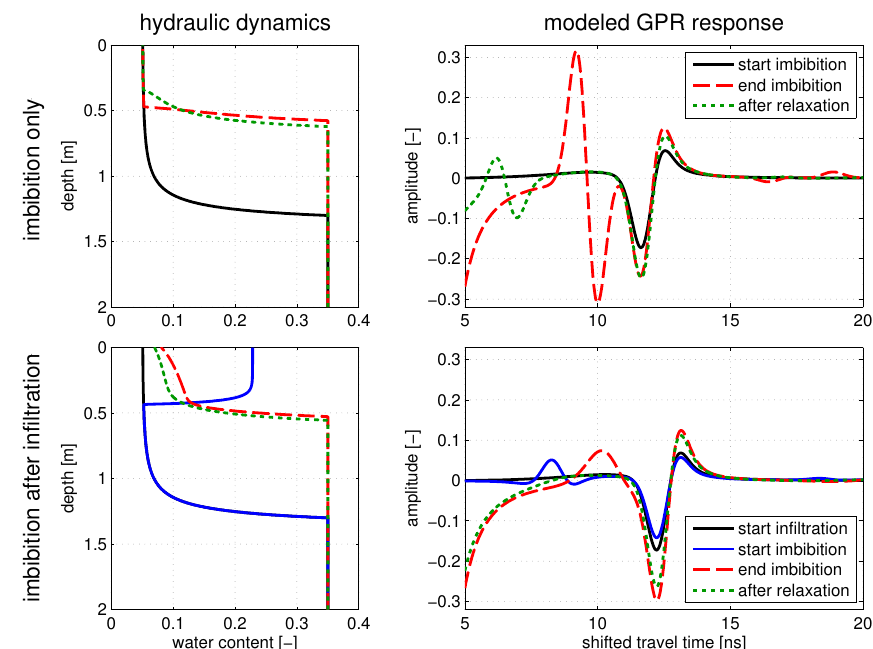
Figure 12. Comparing hydraulic dynamics (left panels) and the corresponding CFR GPR response (right panels) of a modeled 1-D sand C- profile subjected to imbibition into dry sand followed by a period of relaxation (top panels) and the same imbibition after an additional infiltration event, pre-wetting the sand (bottom panels). For clarity, the GPR wavelets have been shifted to coincide at the minimum feature of the equilibrium CFR. Direct waves and the additional wetting front reflection in the pre-wetted case (arriving at travel times between 0 and 5ns) are not shown for